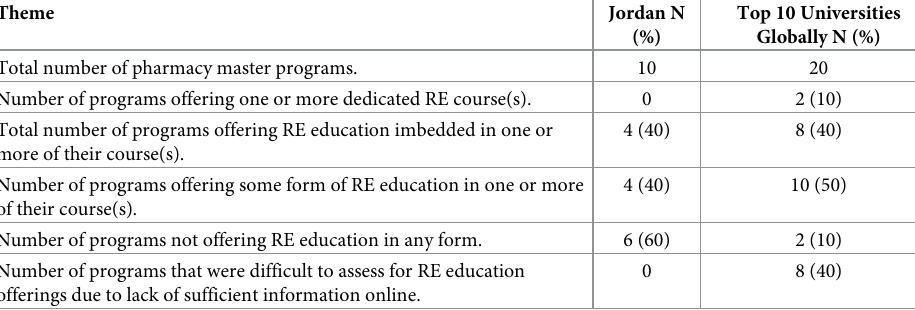
Top 10 Universities (%) Globally N (%) 4 (40) 8 (40) 4 (40) 10 (50) 0 8